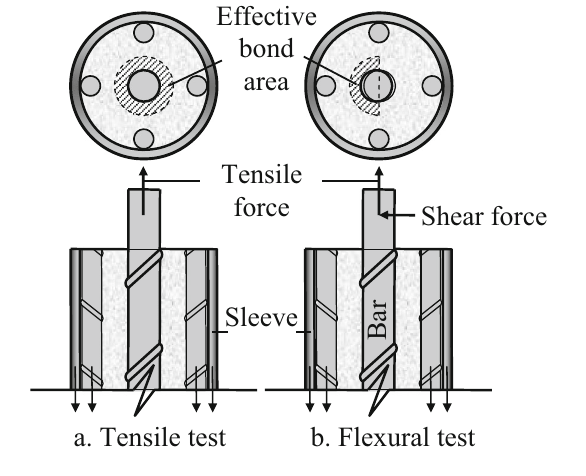
Fig. 15 Comparison of the effective bond areas under tensile and flexural loads (Ling